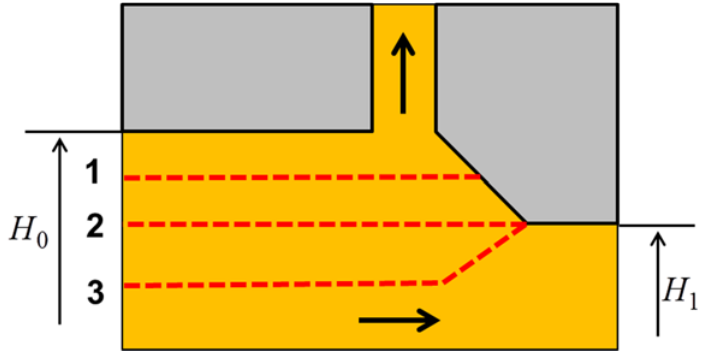
Figure 9. The conditional boundaries of the metal flows for the three possible PFM modes: Mode 1: P BP < P BP 1 ; Mode 2: P BP 1 ≤ P BP ≤ P BP 2 ; Mode 3: P BP > P BP 2